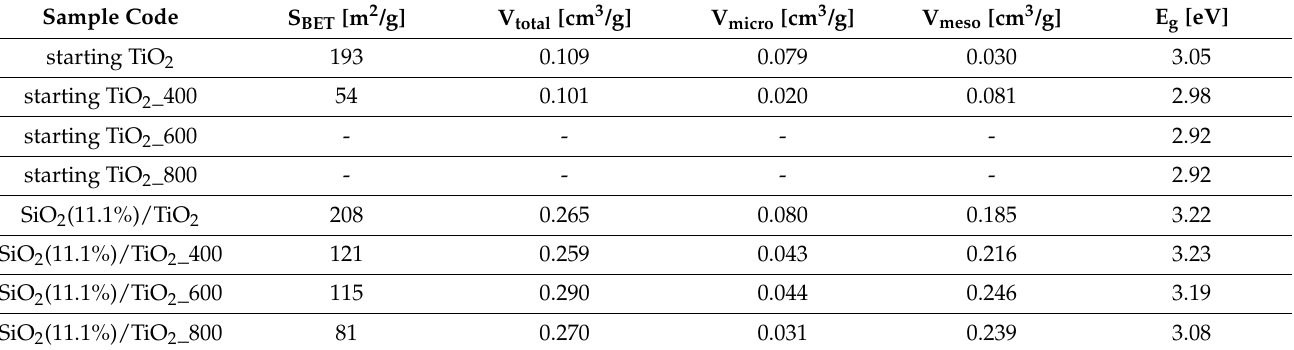
Table 2. Specific surface area and band gap energy.